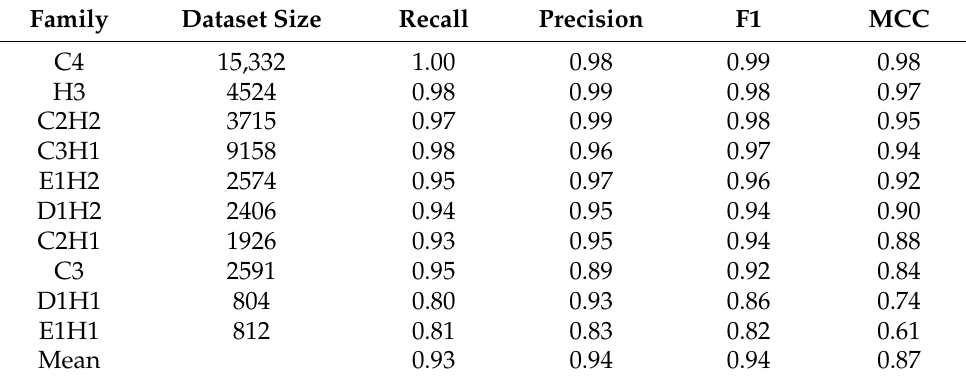
Table 2. Results for sequence models, sorted by Matthews Correlation Coefficient